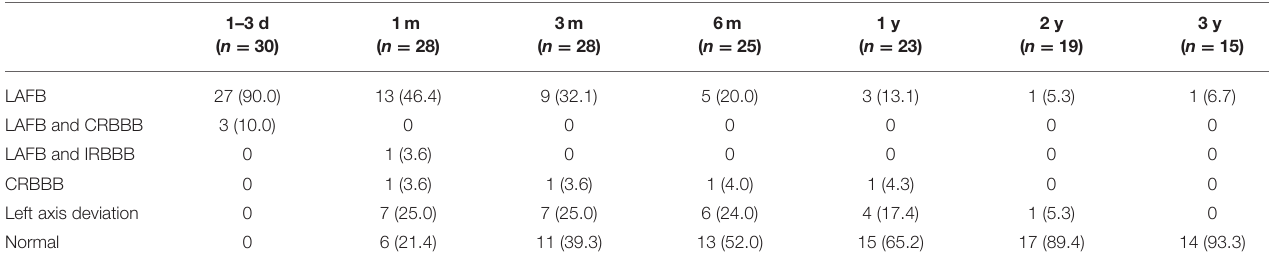
TABLE 2 | Follow-up data of ECG [ n (%)].